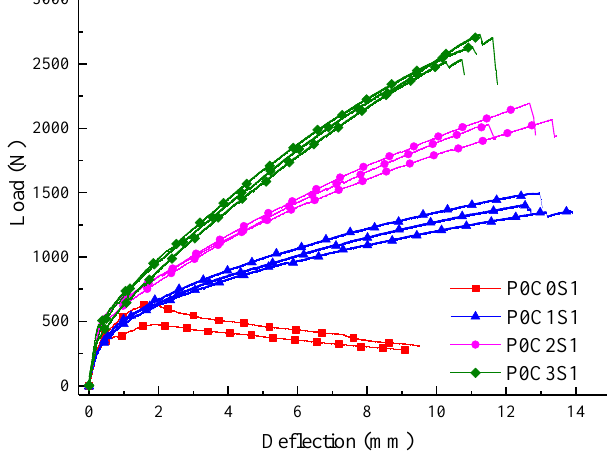
Figure 13. Load-deflection curves of the TRC specimens with 1% volume content of steel fibres.